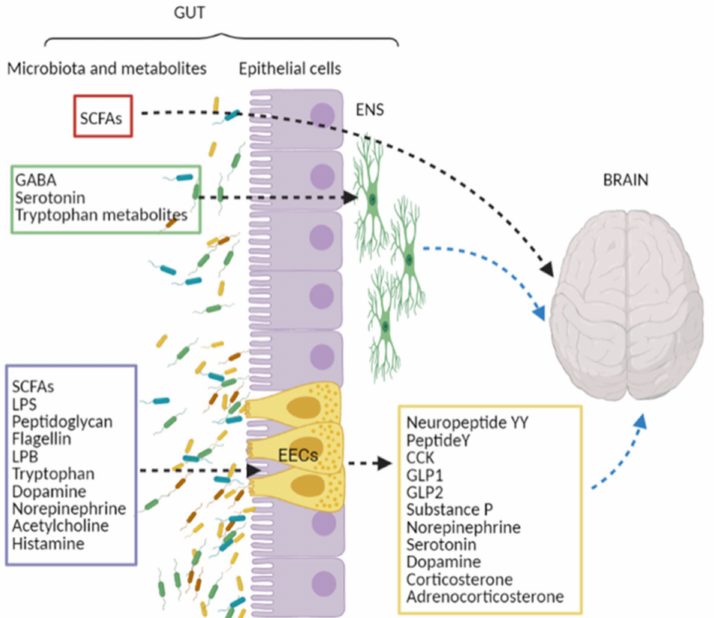
Figure 1. Neuro-signals from the gut. Bacterial derived molecules reported in (i) violet square can stimulate enteroendocrine cells (EECs) to release neuroactive molecules (yellow square), which affect brain functions through the vagal route (dotted blue arrow); (ii) green square can act on neurons of enteric nervous system (ENS) modulating brain functions through the vagal nerve; (iii) red square directly affect brain function passing the blood-brain barrier. SCFAs, short chain fatty acids; GABA, g-amino butyric acid; LPS, lipopolysaccharide; LBP, LPS binding protein; CCK, cholecystokinin; GLP-1/GLP2, glucagon-like peptide 1 and